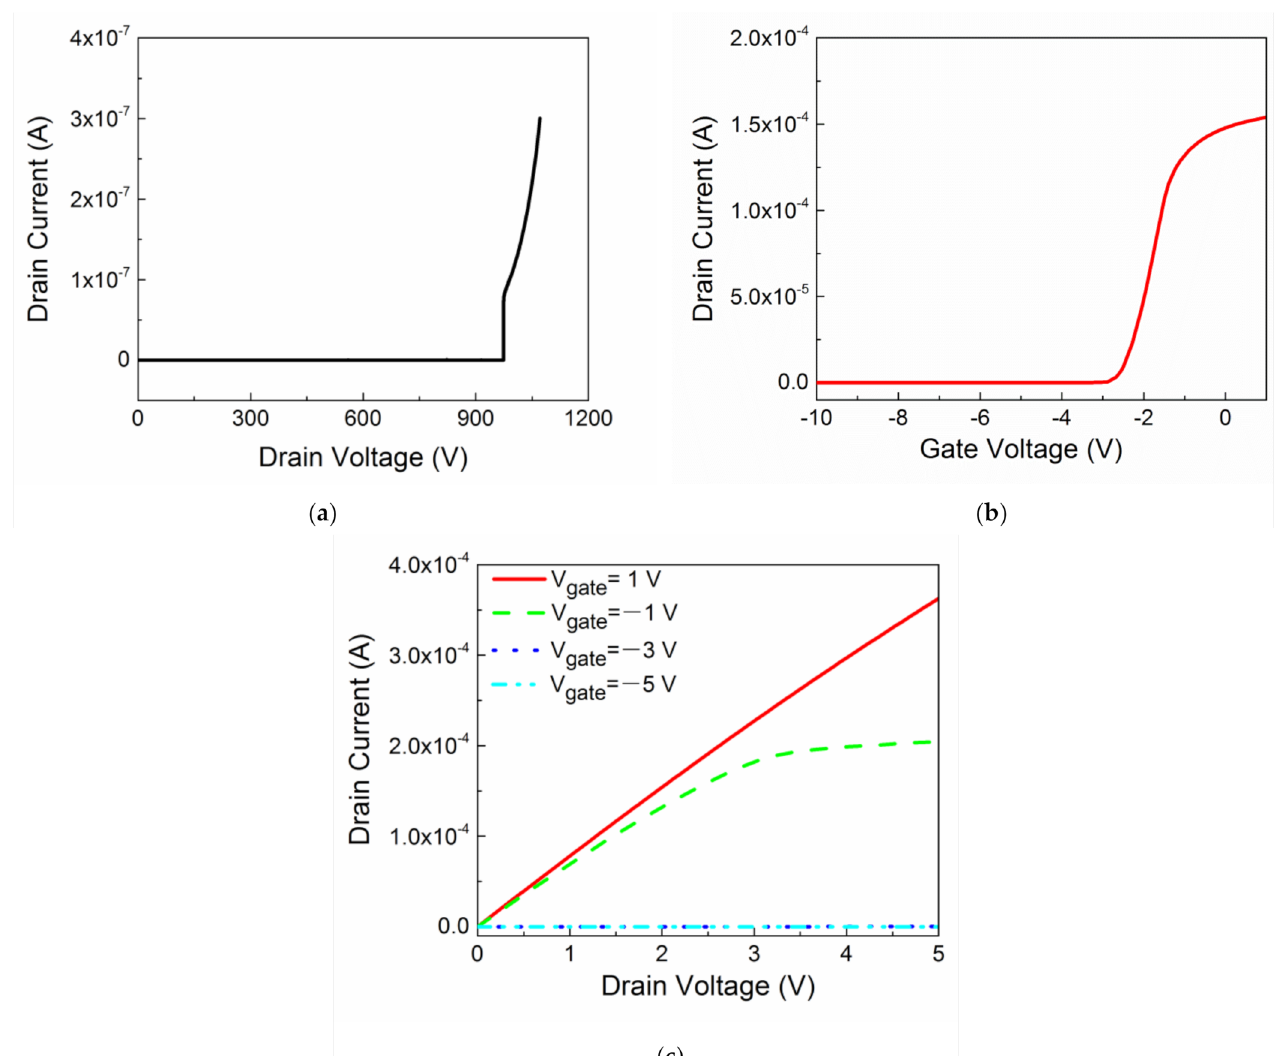
Figure 3. The characteristics of the depletion-mode AlGaN/GaN HEMT: ( a ) the breakdown characteristic, ( b ) the transfer characteristic, and ( c ) the output